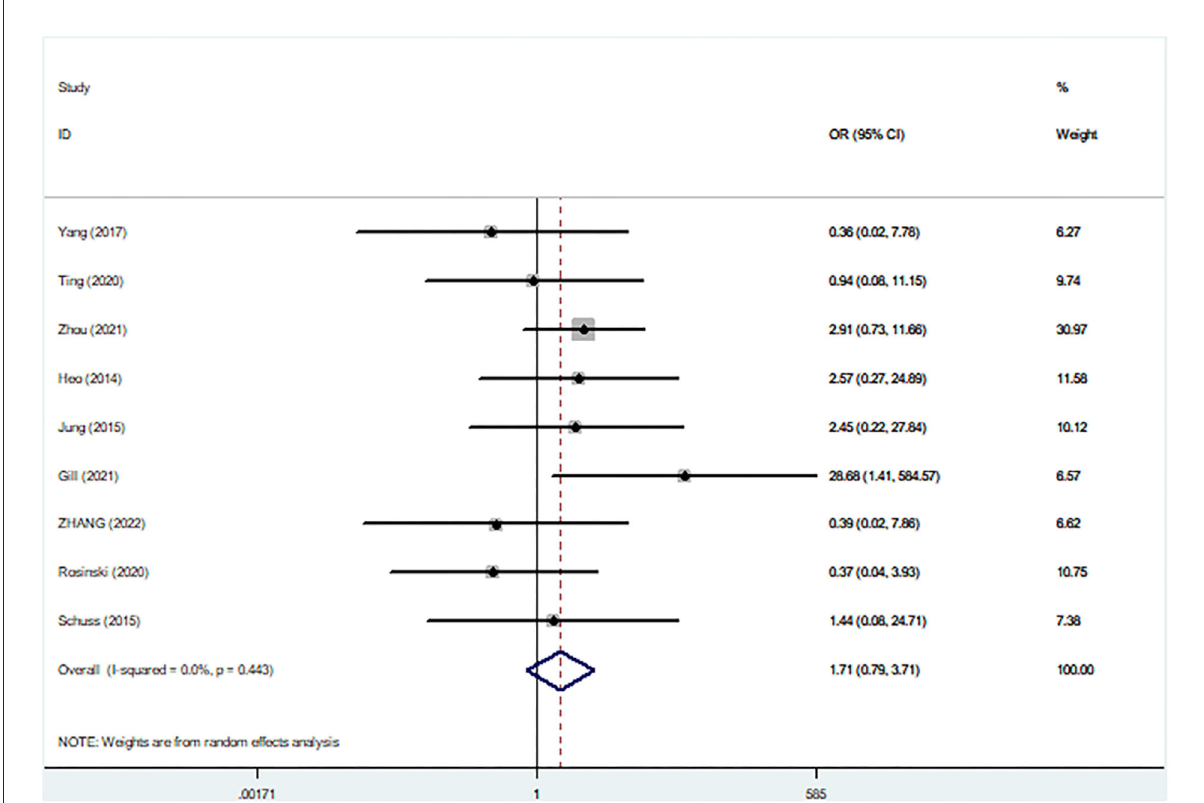
FIGURE6 Comparisons of post-operative bleeding complications between staged and simultaneous cranioplasty and ventriculoperitoneal shunts. OR, odds ratio; CI, confidence